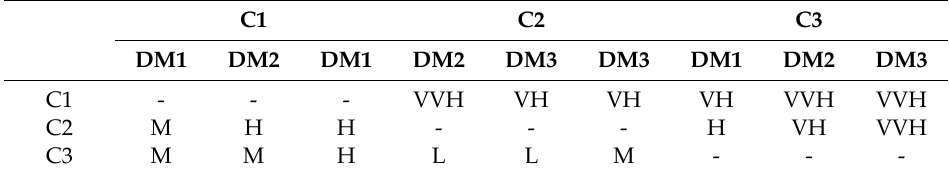
Table A2. Linguistic evaluations of the criteria for dimension